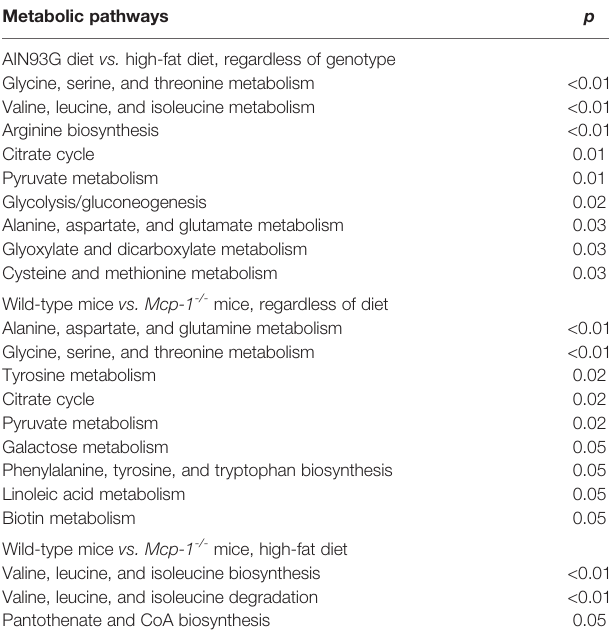
TABLE 5 | Metabolic pathways identi fi ed by the pathway analysis that are signi fi cantly altered in MMTV-PyMT mice. KEGG pathway